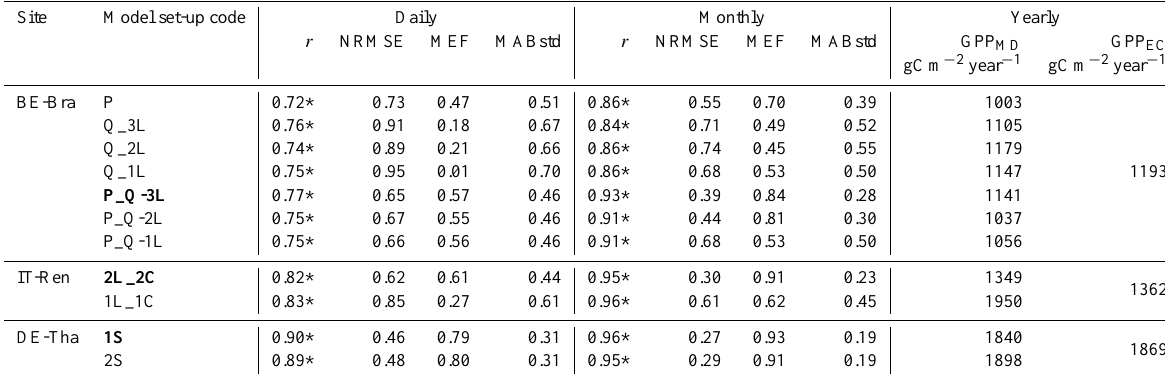
Figure 8. Distribution of the magnitude for the inter-monthly variability values (IMVs, gCm − 2 day − 1 ) for each specific site, derived by standard kernel density estimation. The vertical red line is the media, the box plot limit the 25th and 75th percentiles, the dashed black bars represent the rest of the distribution range excluding outliers (red crosses). DE-Tha refers to the 1S simulation, IT-Ren to the 2L_2C simulation, BE-Bra to the P_Q-3L simulation (see text). Table 3. Performance statistics ( r , NRMSE, MEF, MABstd) are reported as derived from daily and monthly series of GPP EC and GPP MD values over long-term annual scale, for the different forest structure simulations. The (*) refers to p value < 0.0001 in correlation between GPP EC and GPP MD data. In addition, long-term average of annual GPP MD and GPP EC values (gCm − 2 year − 1 ) for the different forest structures are